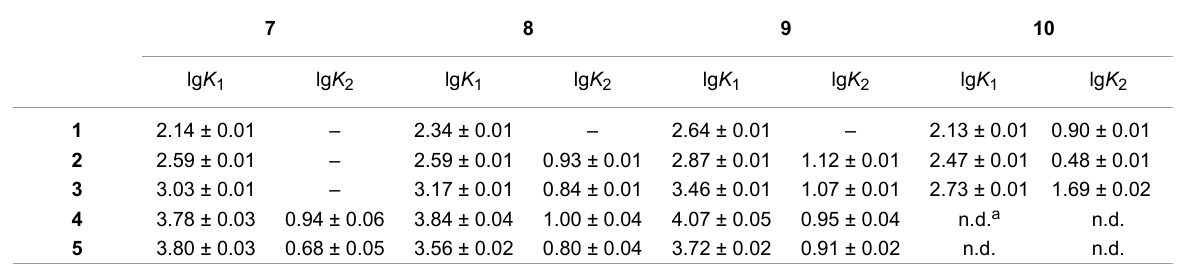
Table 2: Complex stability constants of molecular clips 1 – 5 with guests 7 – 10 in acetonitrile at 20 °C.